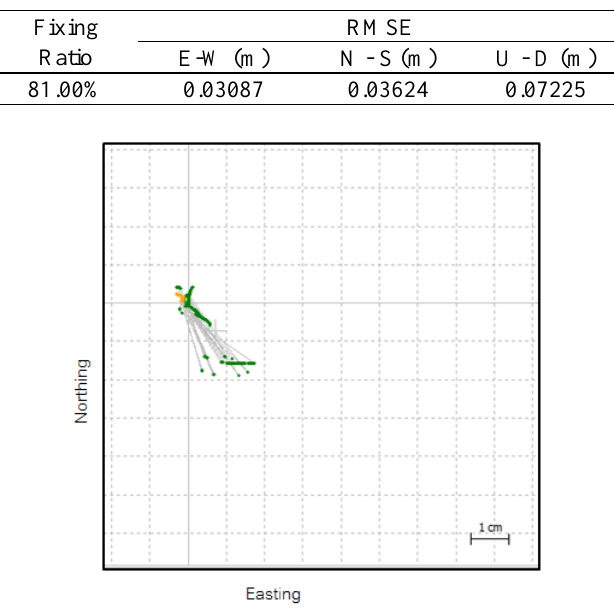
Fig. 12. Plot of the RTK horizontal position components from dual frequency GPS module observation on open sky